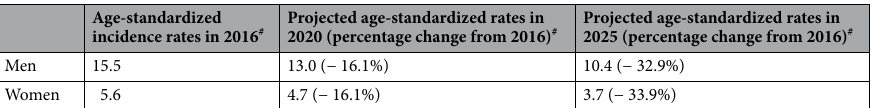
Projected age-standardized rates in 2025 (percentage change from 2016) #